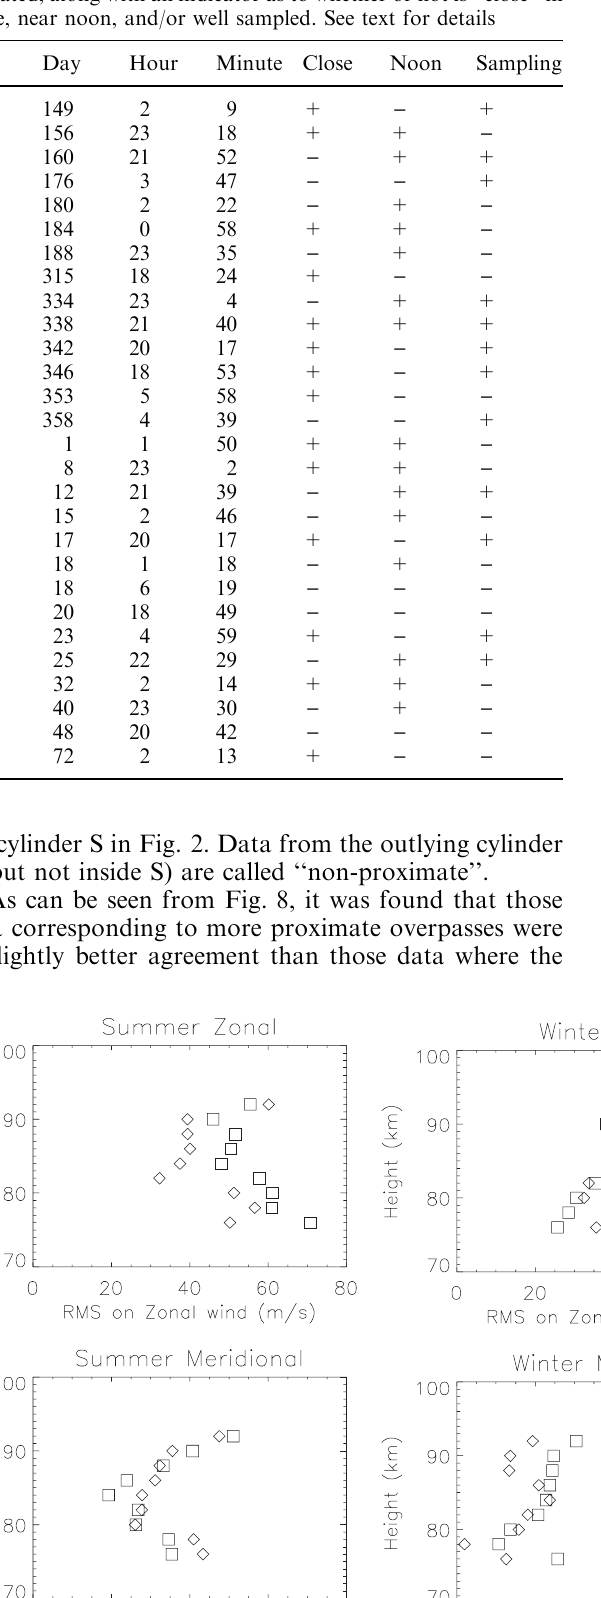
Fig. 7. RMS di(cid:128)erences between the winds separated into data obtained less than three hours from the local noon (diamonds) and data obtained more than three hours from the local